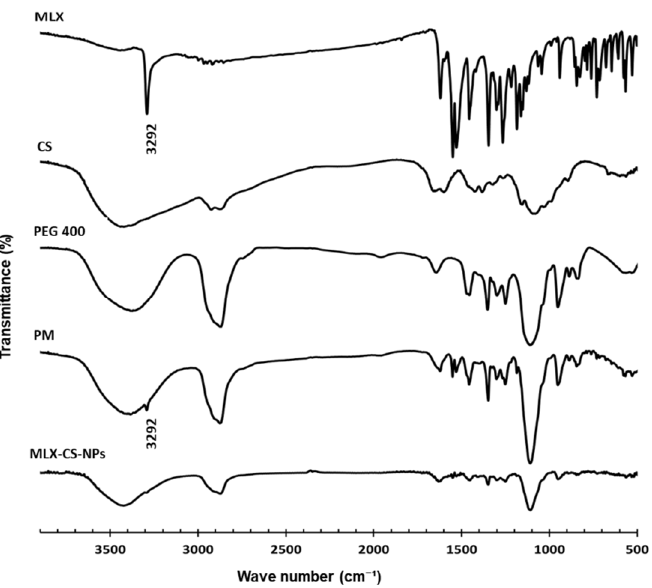
Figure 2. FTIR spectra of meloxicam (MLX), chitosan (CS), PEG 400, their physical mixture (PM), and MLX-CS-NPs. Abbreviations: MLX-CS-NPs; MLX/chitosan nanoparticles.